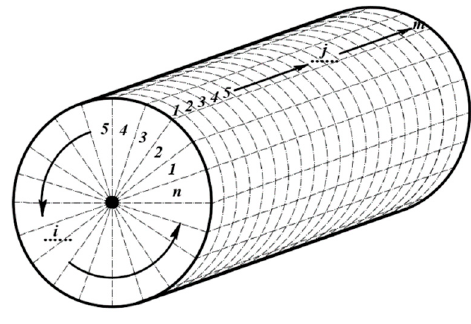
Figure 10. Shield discretization.